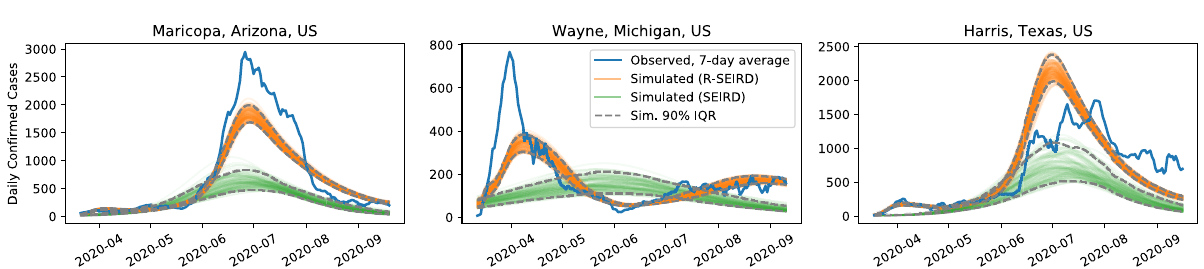
Figure 2. Simulations of the learned R-SEIRD and learned SEIRD systems on the three counties the models are not trained on. The trajectory in blue is the 7-day moving average of observed daily confirm cases. These results demonstrate the generalizability of our model against unseen data. We show representative results across different geographic regions of how our model can more accurately predict the different signatures of disease progression. Note that the SEIRD model consistently under-estimates the prevalence of disease spread, which has significant implications for policy-making decisions on the severity of